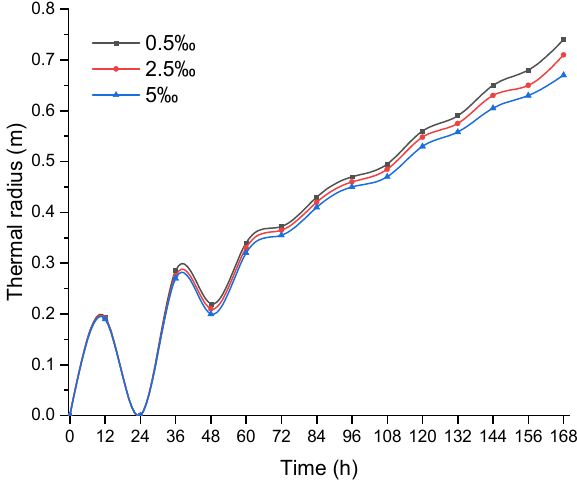
Figure 6. The indicator for determining the thermal radius sensitivity analysis results.